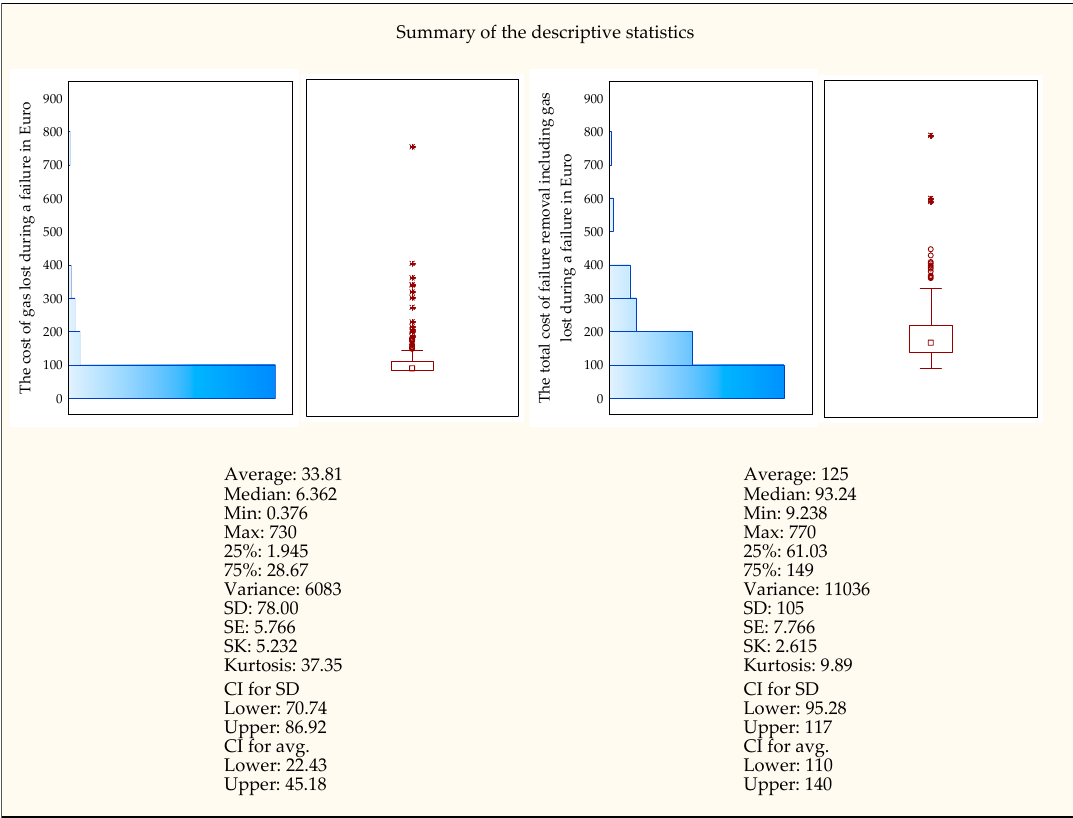
Figure 2. Descriptive statistics regarding the cost of gas lost during a failure in Euros.